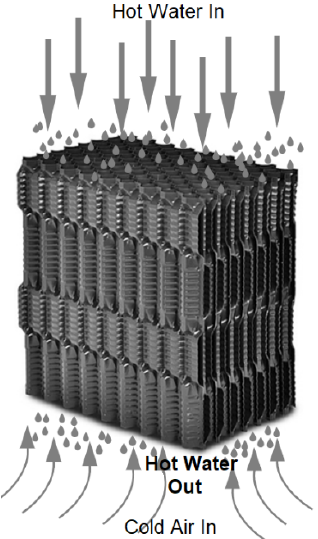
Figure 3. Working principles of cooling tower fills .